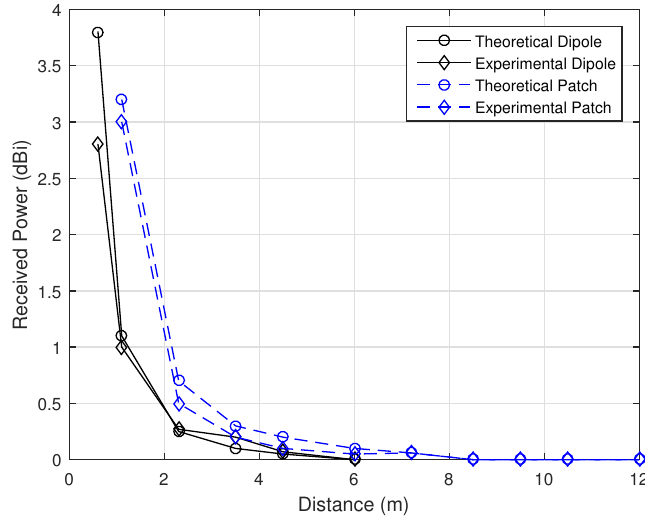
Figure 10. The theoretical versus practical power results for different distances.